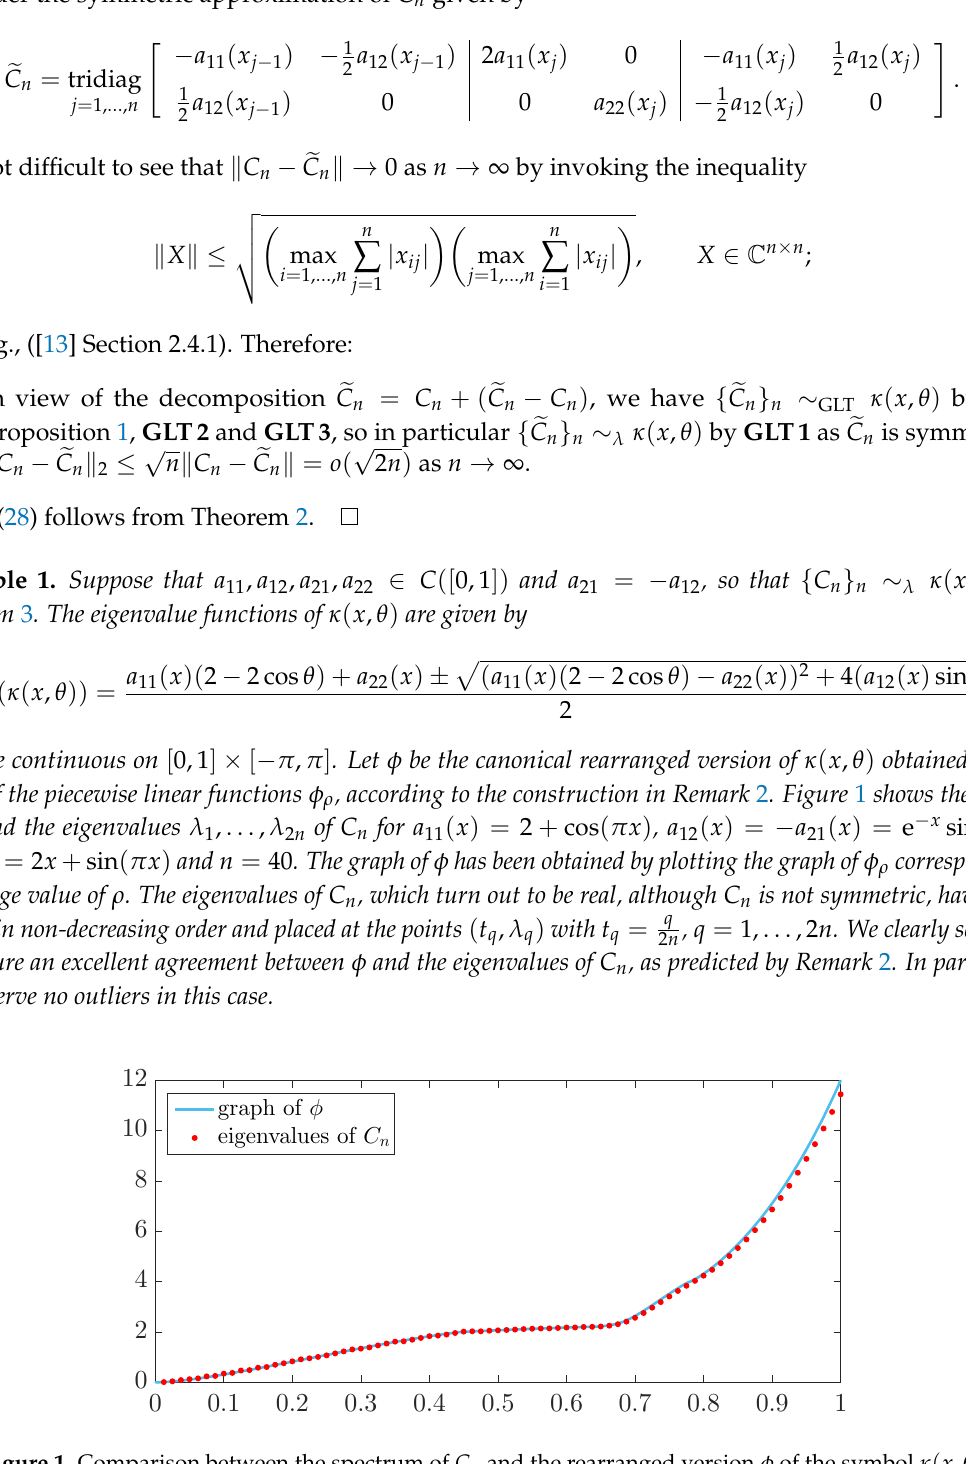
Figure 1. Comparison between the spectrum of C n and the rearranged version φ of the symbol κ ( x , θ ) for a 11 ( x ) = 2 + cos ( π x ) , a 12 ( x ) = − a 21 ( x ) = e − x sin ( π x ) , a 22 ( x ) = 2 x + sin ( π x ) and n =